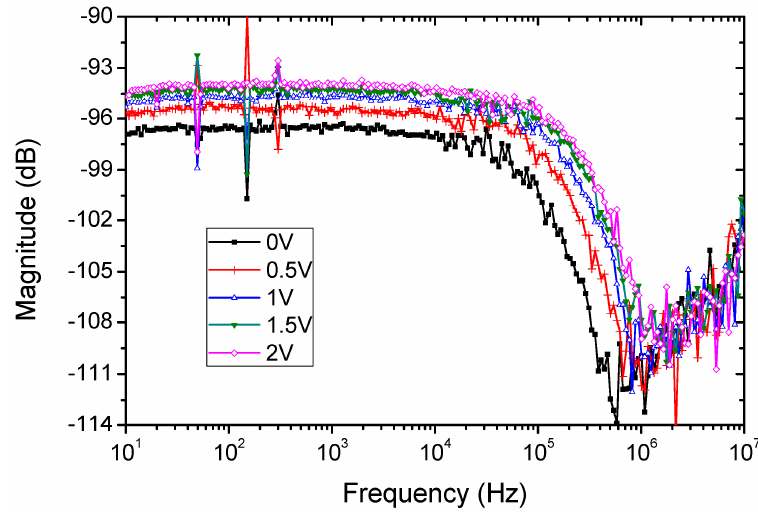
Figure 7. OPD bandwidth measured using a lock-in amplifier.